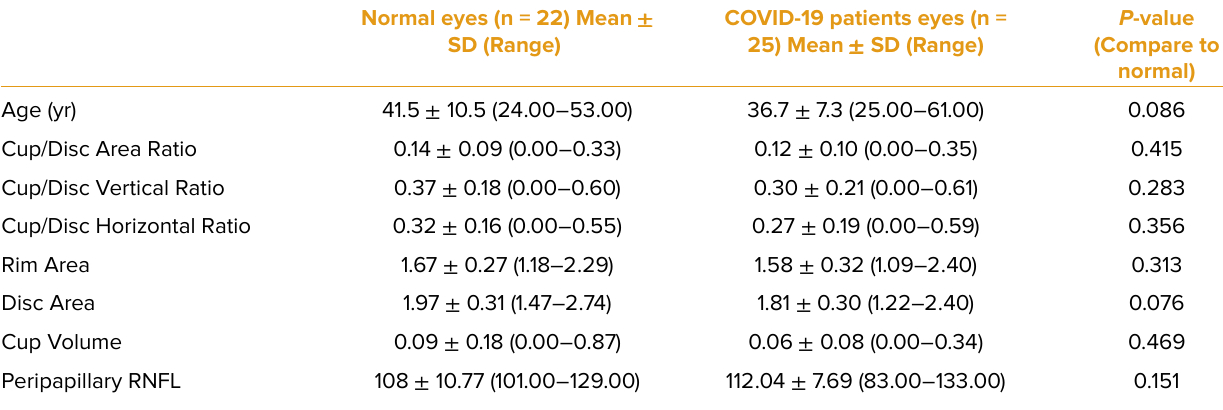
Table 1. Comparison of optic nerve head parameters and age of COVID-19 patients eyes versus normal eyes